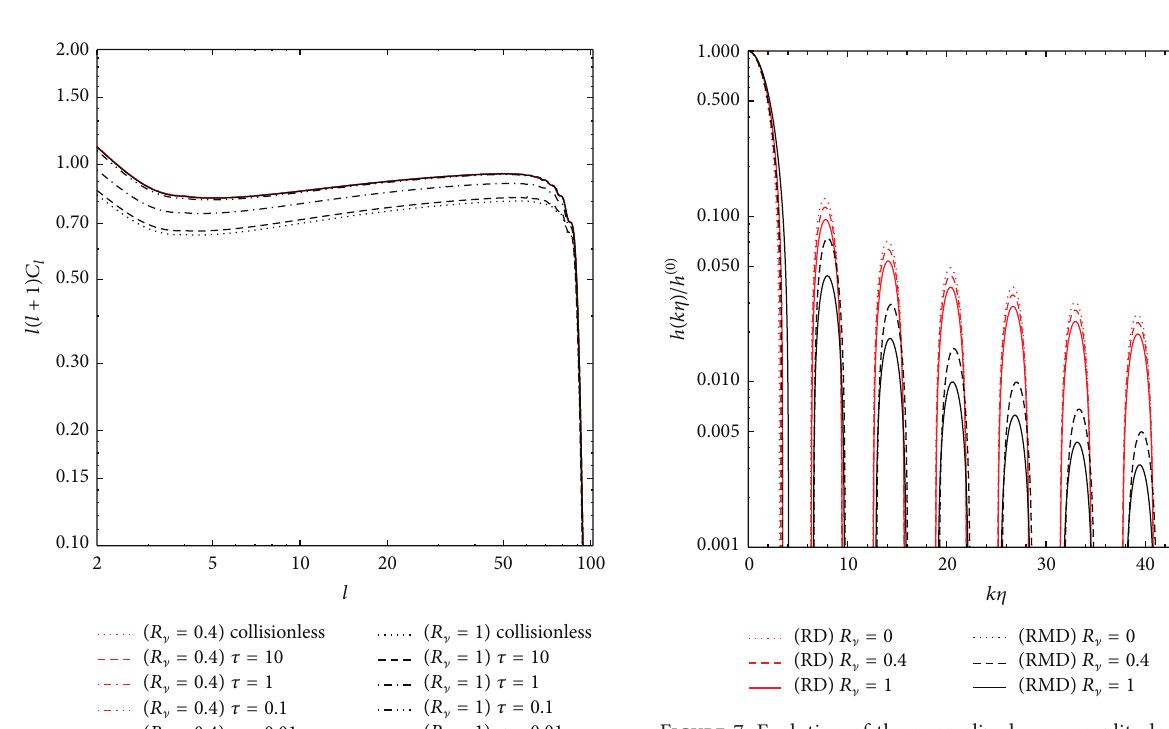
Figure 7: Evolution of the normalized wave amplitude ℎ 𝑖𝑗 /ℎ (0) 𝑖𝑗 as function of 𝑘𝜂 for RD (red lines) and RMD (black lines) background cosmic inventories, in correspondence with Figure 1. Again, the RD curves are scale independent and the RMD curves are correctly = 100 ,whichcorrespondtoscales interpretedbyobservingthat 𝑘𝜂 eq that have entered the Hubble horizon before the time of matter- radiation